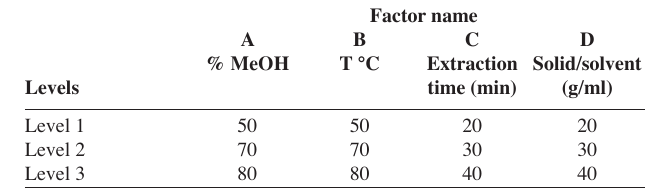
Tab. 1: A three-level (Levels 1-3) and four-factor (A, B, C, D) orthogonal experiment L 9 (3 4 ) evaluating four criteria – total extract (E), total polyphenols (P), total saponins (S), and DPPH radical scavenging activity (R) of the